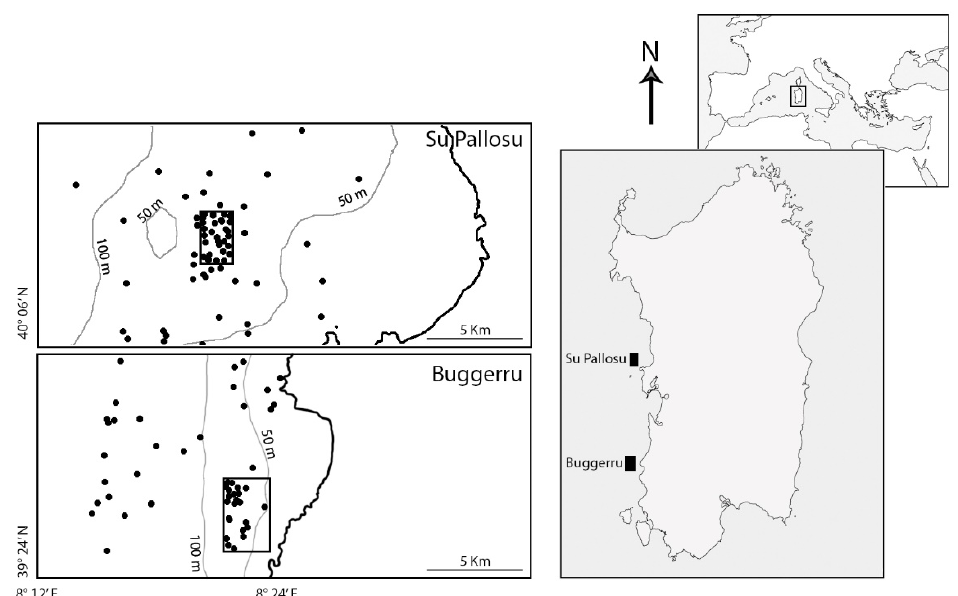
Figure 1. Map of the study areas. Dots inside the rectangles represent replicates (i.e., set of trammel nets) performed inside FPAs, where fishing activities are prohibited. Dots outside the rectangles represent set performed outside FPAs, in neighbouring fishing grounds.